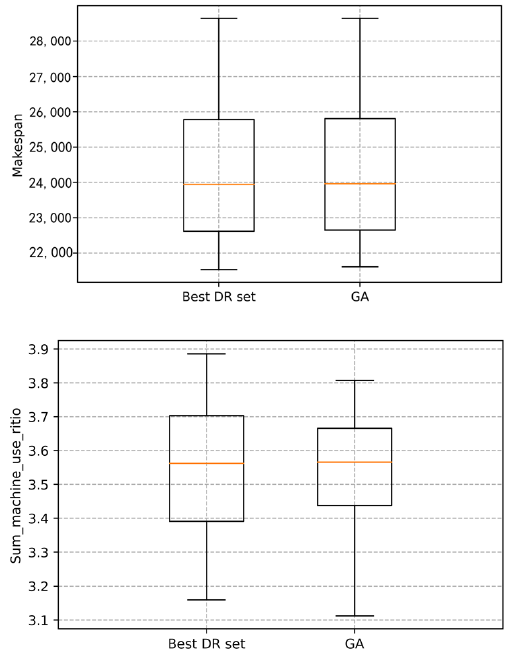
Figure 12. High job heterogeneity and a high manufacturing system load rate.